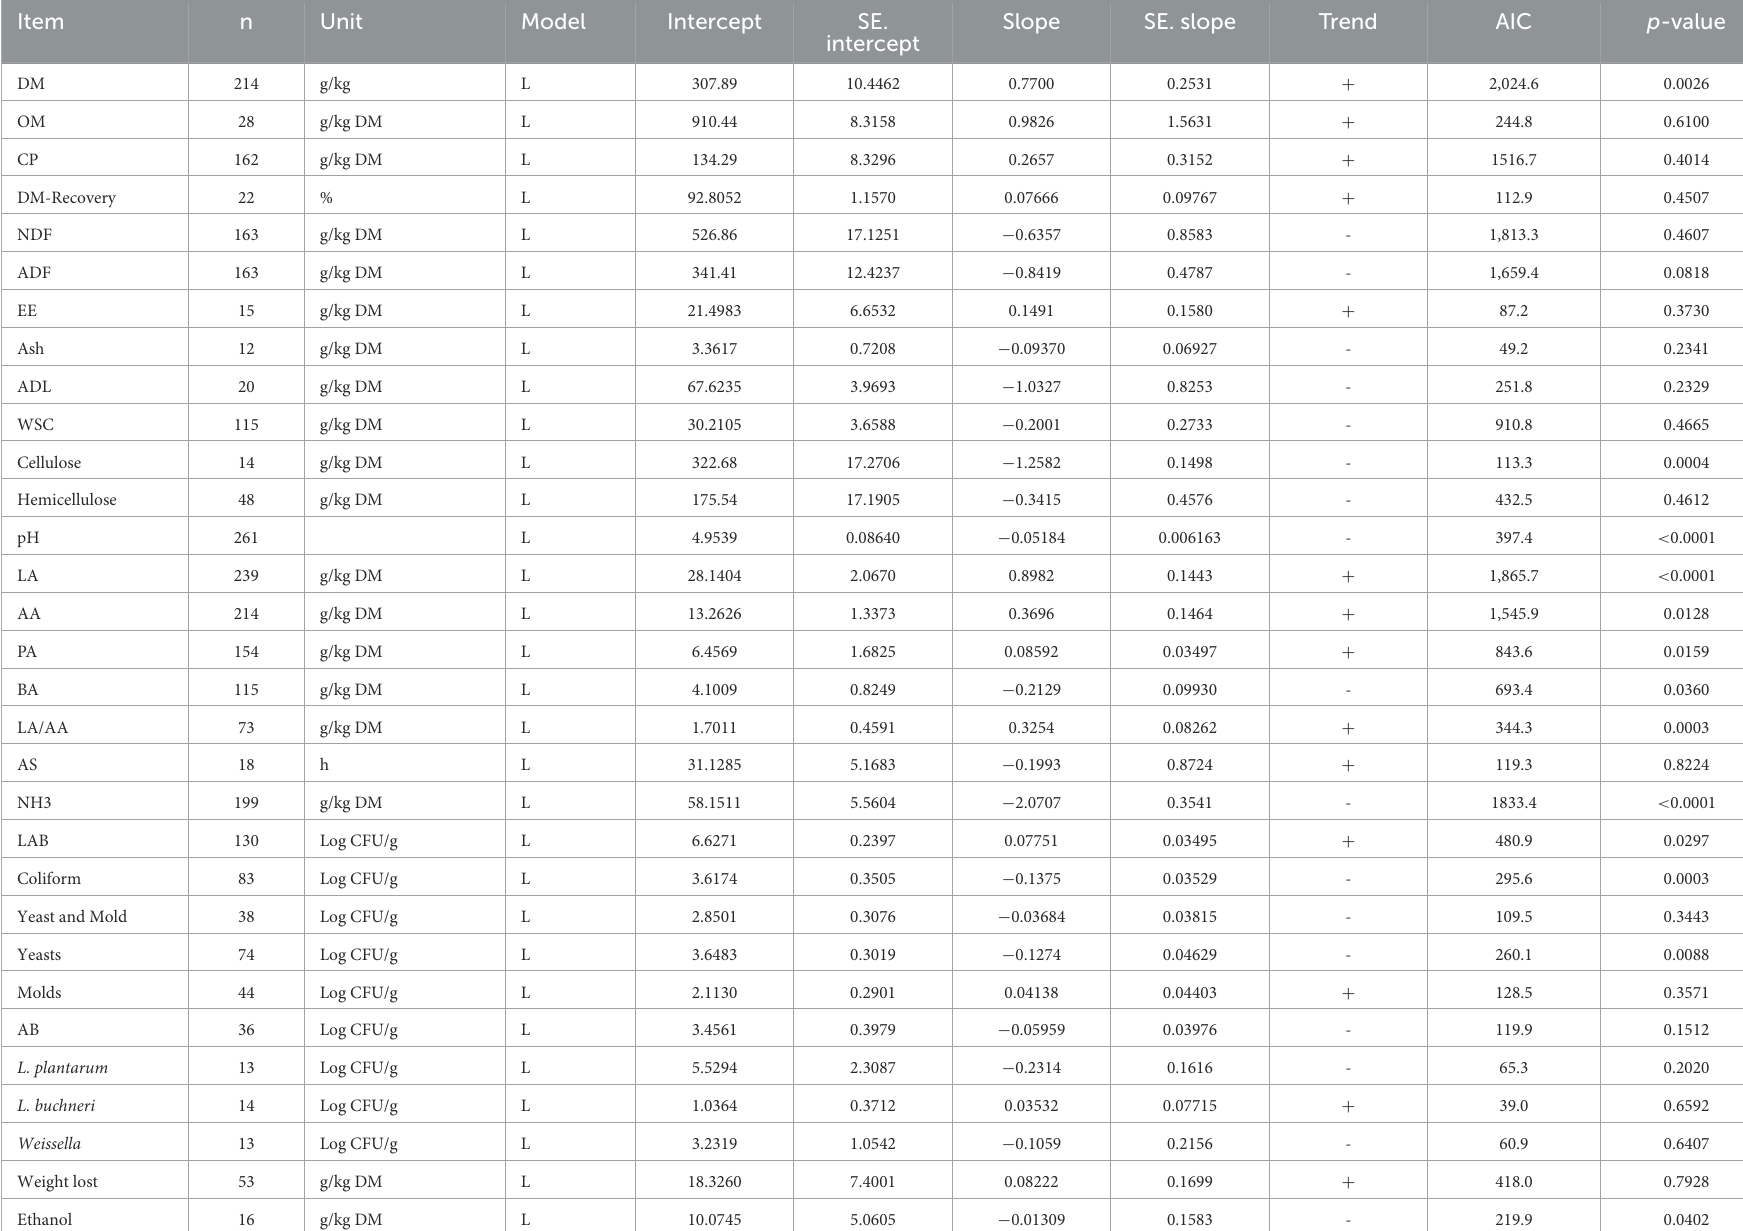
TABLE 5 Effects of lactic acid bacteria on chemical composition and fermentation characteristics post-ensiling process. Item Unit Model Intercept SE.